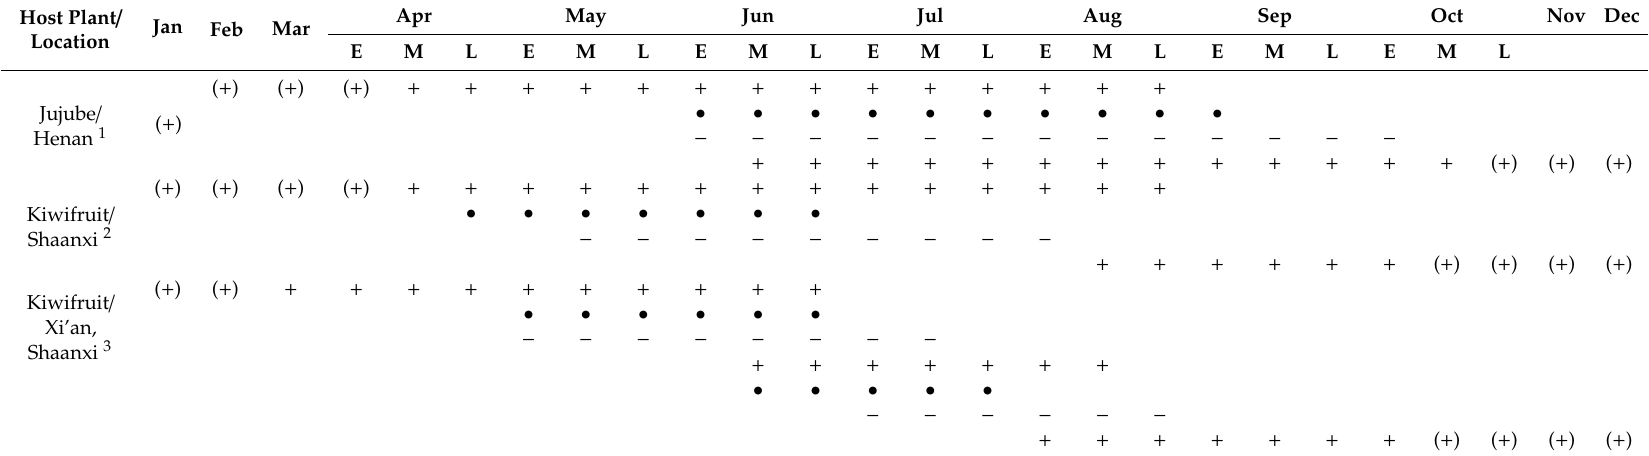
Table 1. Seasonal phenology of univoltine and bivoltine populations of Erthesina fullo on jujube and kiwifruit in northern China. Host Plant